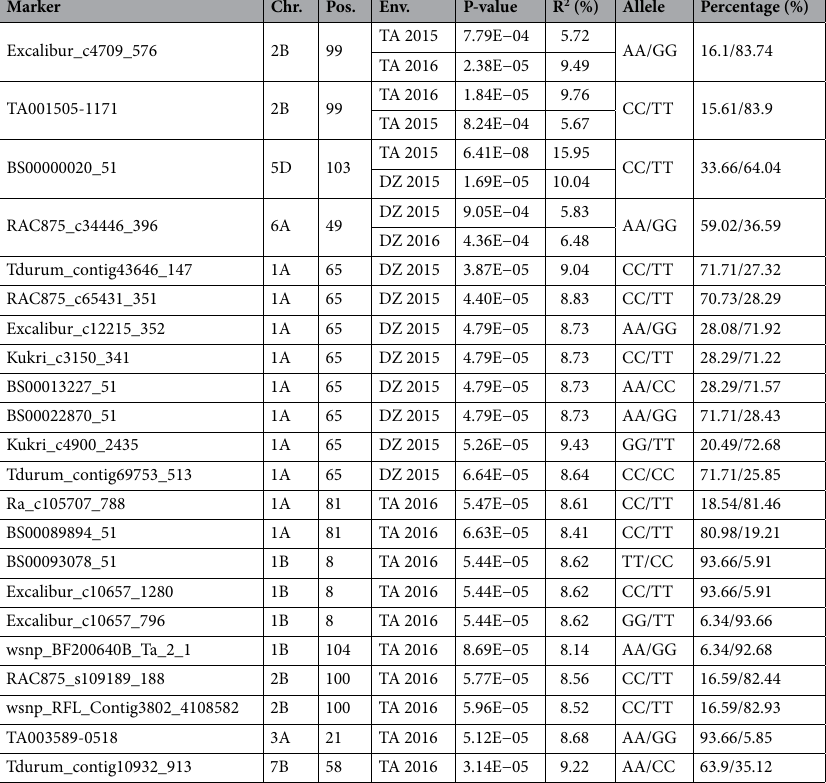
Table 3. SNP markers significantly associated with flour whiteness in two locations in 2 years (P < 10 –4 ). Chr. chromosome, Pos. position, Env. environment.